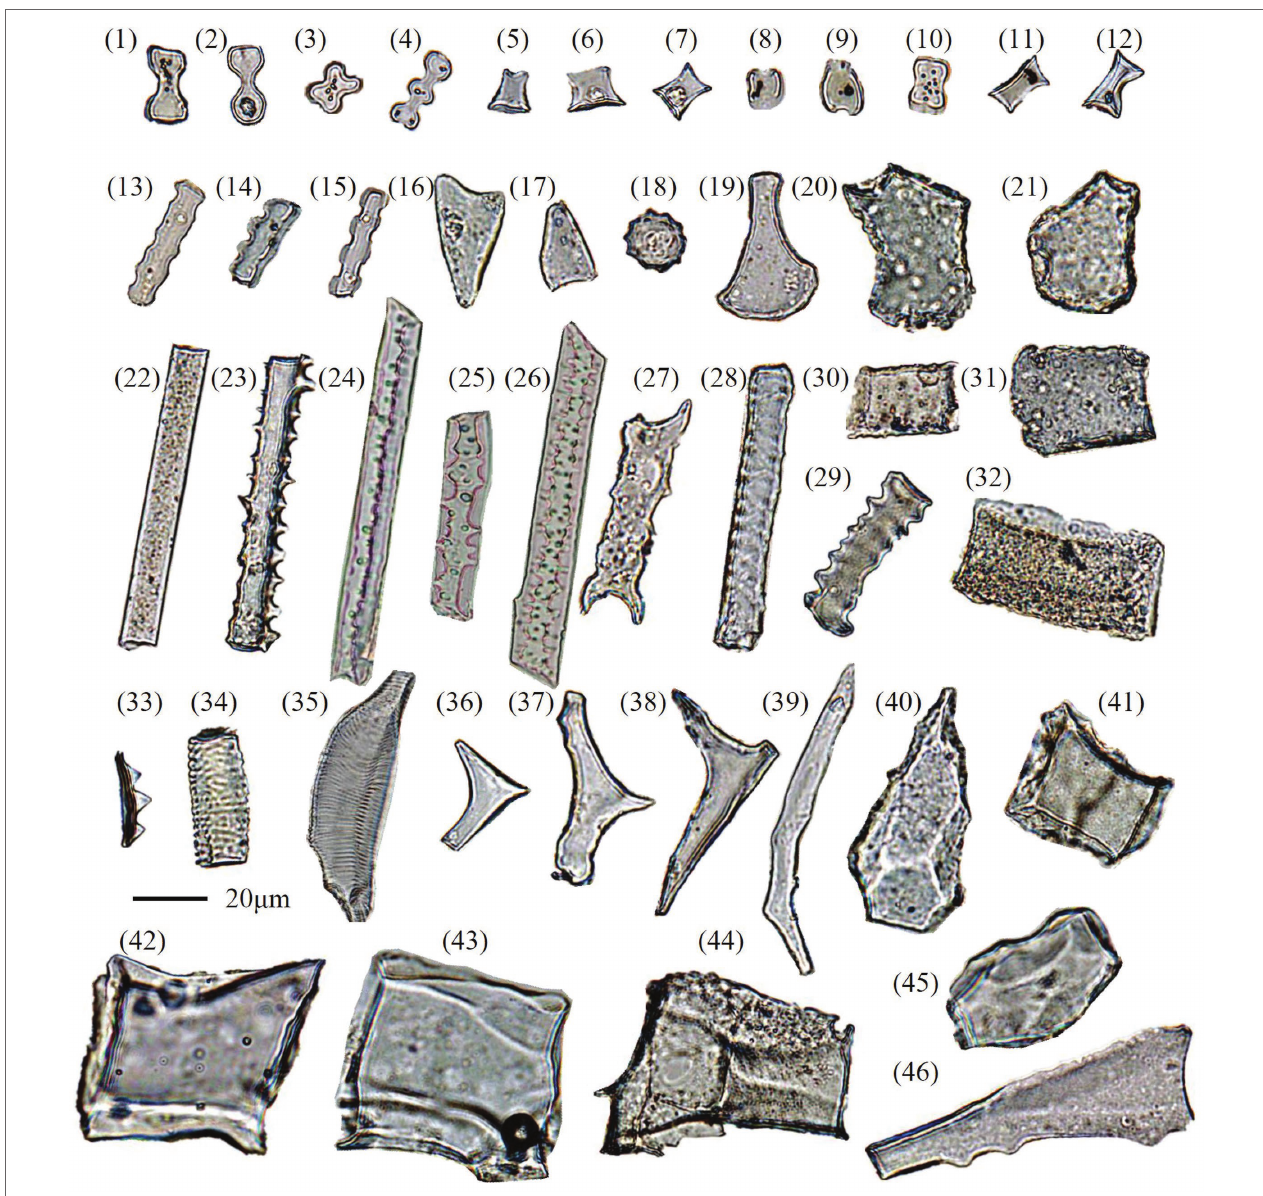
FIGURE 3 | Microphotographs of selected phytolith types recovered from topsoil samples under different vegetation communities in the Daiyun Mountains, southeastern China. (1–2) B ilobate ; (3) C ross ; (4) P olylobate ; (5–7) R ondel ; (8–12) S addle ; (13–15) C renate ; (16–17) A cute bulbosus ; (18) S pheroid echinate ; (19–21) B ulliform flabellate ; (22) E longate entire ; (23, 27, 29) E longate dentate ; (24–26) E longate sinuate (Pteridophyte, cf . Lu et al., 2006); (28) E longate tabular ; (30–32) B locky ; (33) P apillate ; (34–35) T racheary annulate / helical (woody species, cf . Lu et al., 2006; Wen et al., 2018); (36–38) B rachiate (woody species, cf . Lu et al., 2006; Wen et al., 2018); (39) E longate geniculate (woody species, cf . Lu et al., 2006; Wen et al., 2018); (40,45) B locky polyhedral (woody species, cf . Lu et al., 2006; Wen et al., 2018); (41–44) B locky (woody species, cf . Lu et al., 2006; Gao et al., 2018); (46) unclassified (woody